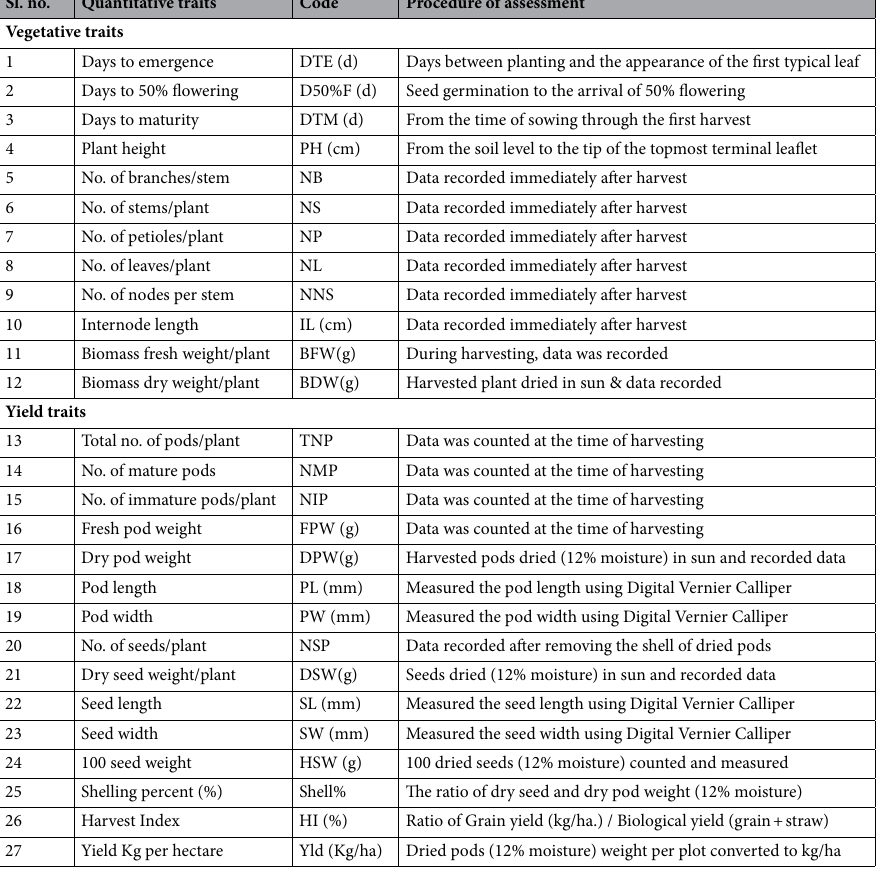
Table 4. Twenty-seven quantitative traits measured according to IPGRI, IITA, BAMNET 19 .